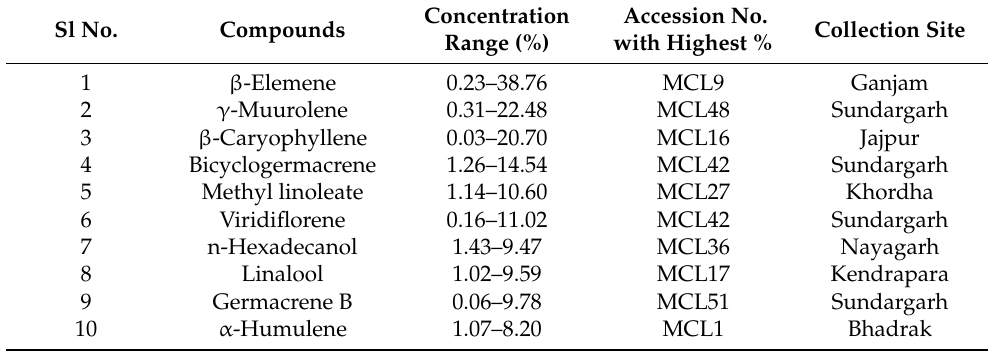
Table 3. Concentration (min and max) of top 10 constituents of Magnolia champaca leaf essential oil as identified by